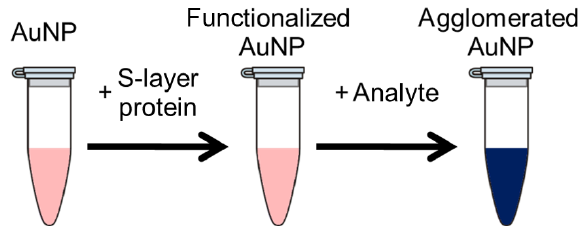
Figure 5. Schematic illustration of the colorimetric detection method using S -layer-functionalized